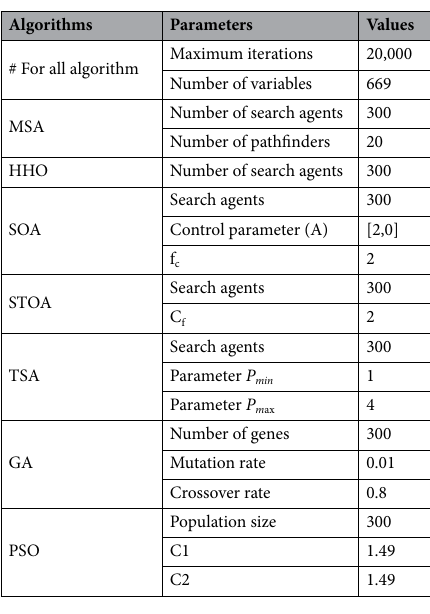
Table 1. Parameter setting values for algorithms.